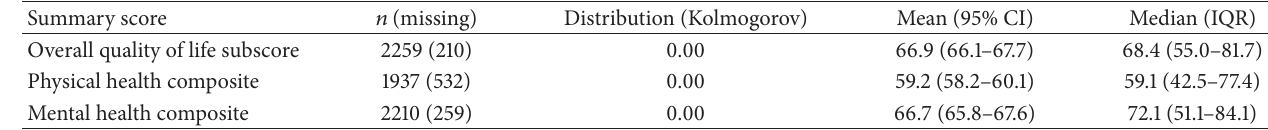
Table 7: MSQOL summary scores.